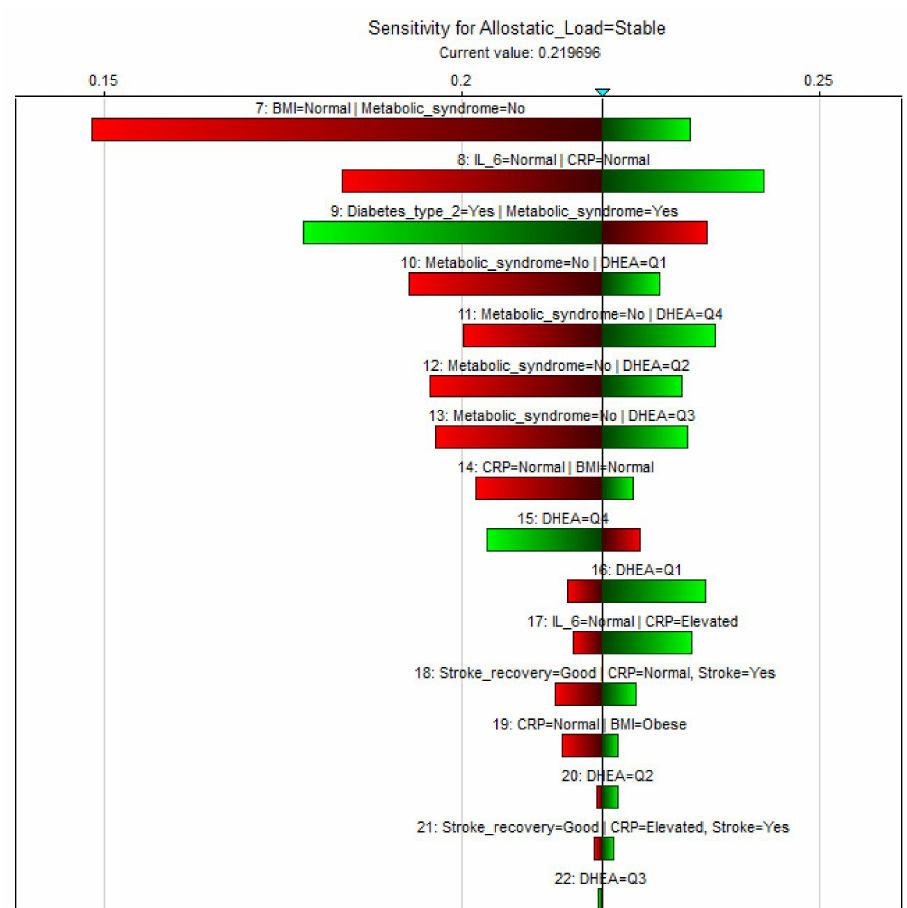
Figure 4. Tornado plot of sensitivity analysis performed in GeNIe software. Label represents observed state, length of color bar represents magnitude of influence on model outcome achieved by changing specified state, with the green side of the bar representing the resulting probability that P ( Allostatic _ Load = Stable ) for the states represented, and the red side representing the resulting probability after reversing the observed state (e.g., Metabolic Syndrome absent/present). For example, following this model, the probability of a stable/undisturbed allostatic load given a normal BMI and the established absence of Metabolic Syndrome, with no information on any of the other parameters, would be 29%; while with BMI = obese, though yet no diagnosed Metabolic syndrome, this likelihood would decrease to 16%. Note: BMI = Body mass index; CRP = C-reactive protein; DHEA = Dehydroepiandrosterone; IL-6 =